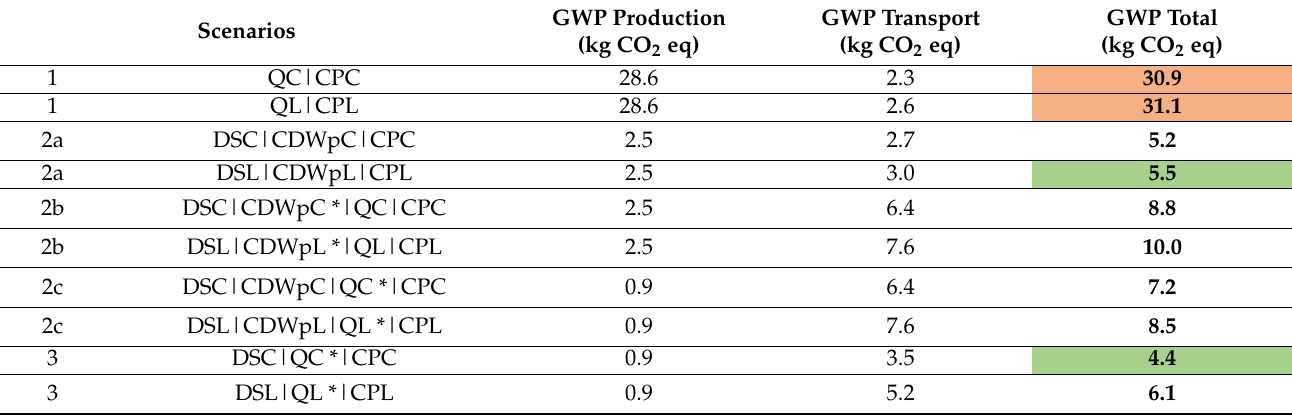
Table 4. GWP for production and transport of 1 tonne of aggregates.